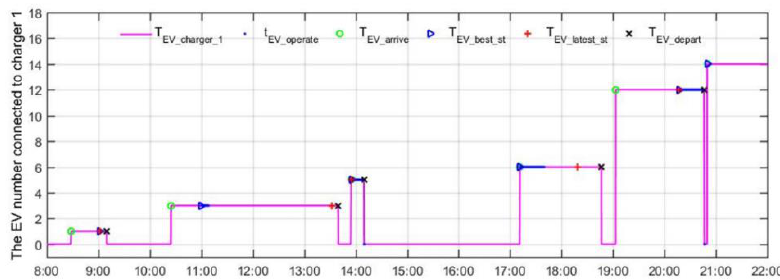
Figure 28. Operating time of EVs connected to charger 1 under